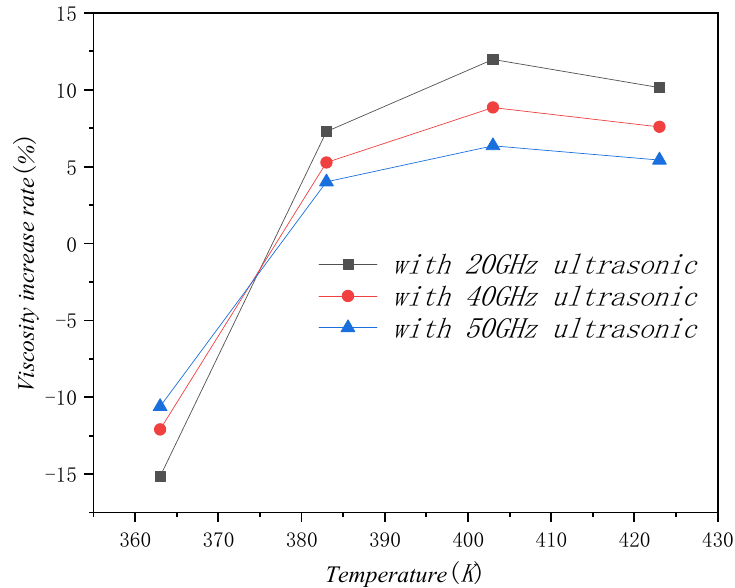
Figure 10. The relation curve of viscosity increases rate of modified asphalt with temperature and frequency under ultrasonic. frequency under ultrasonic.